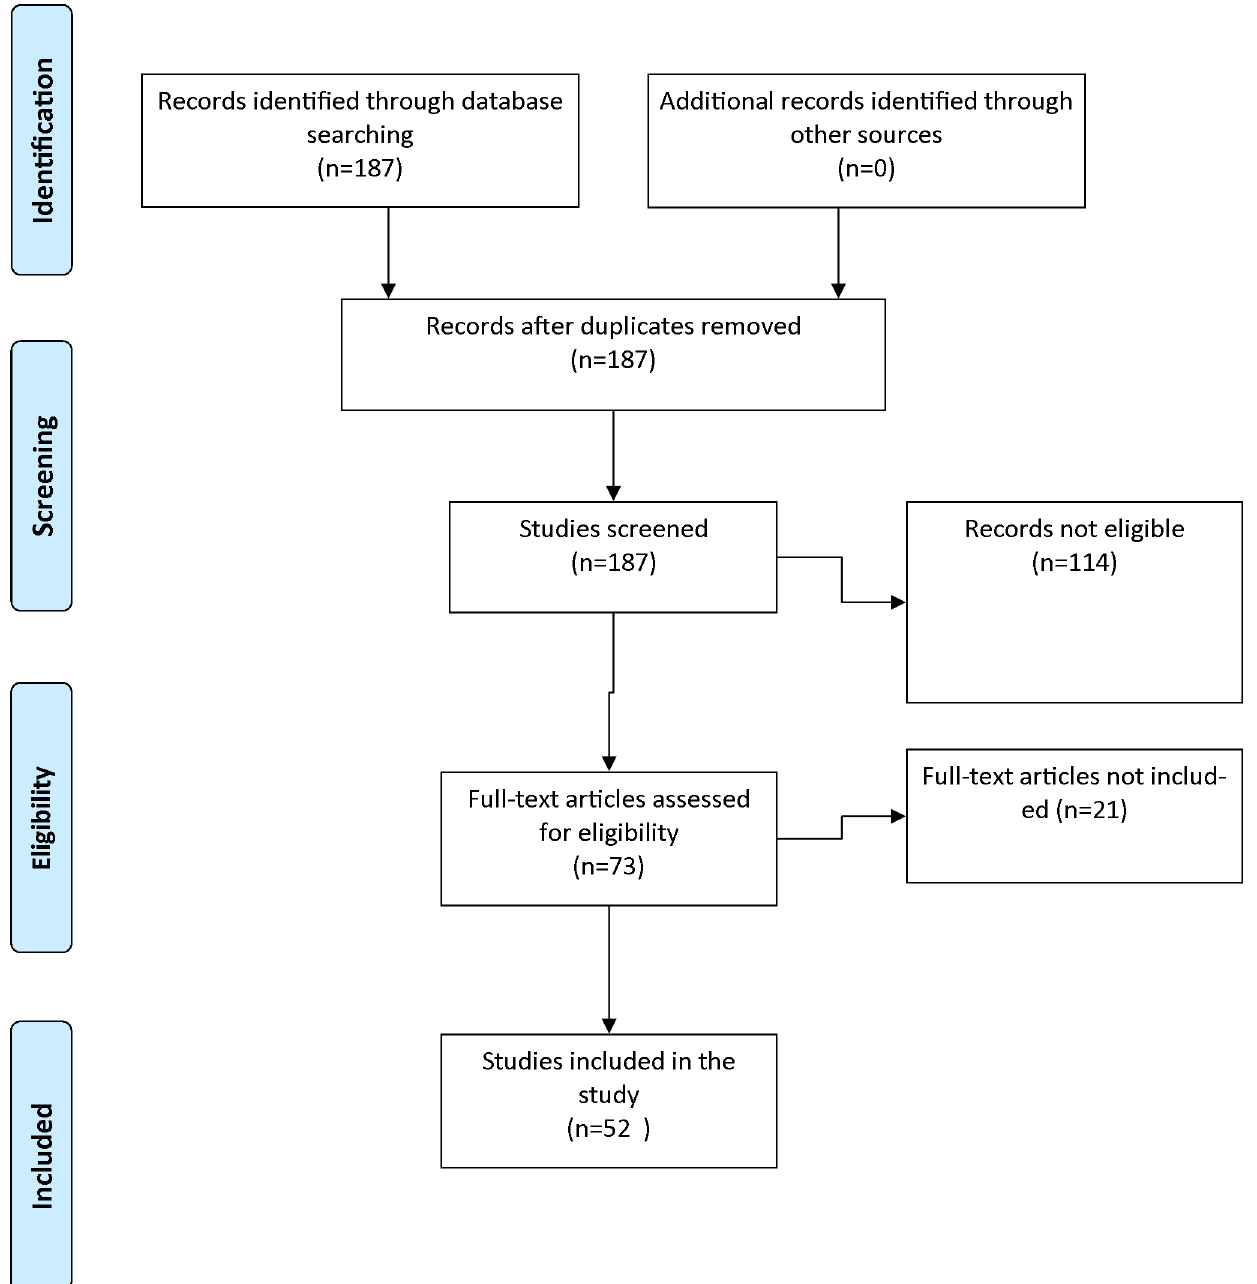
Fig 1. PRISMA 2009 Flow